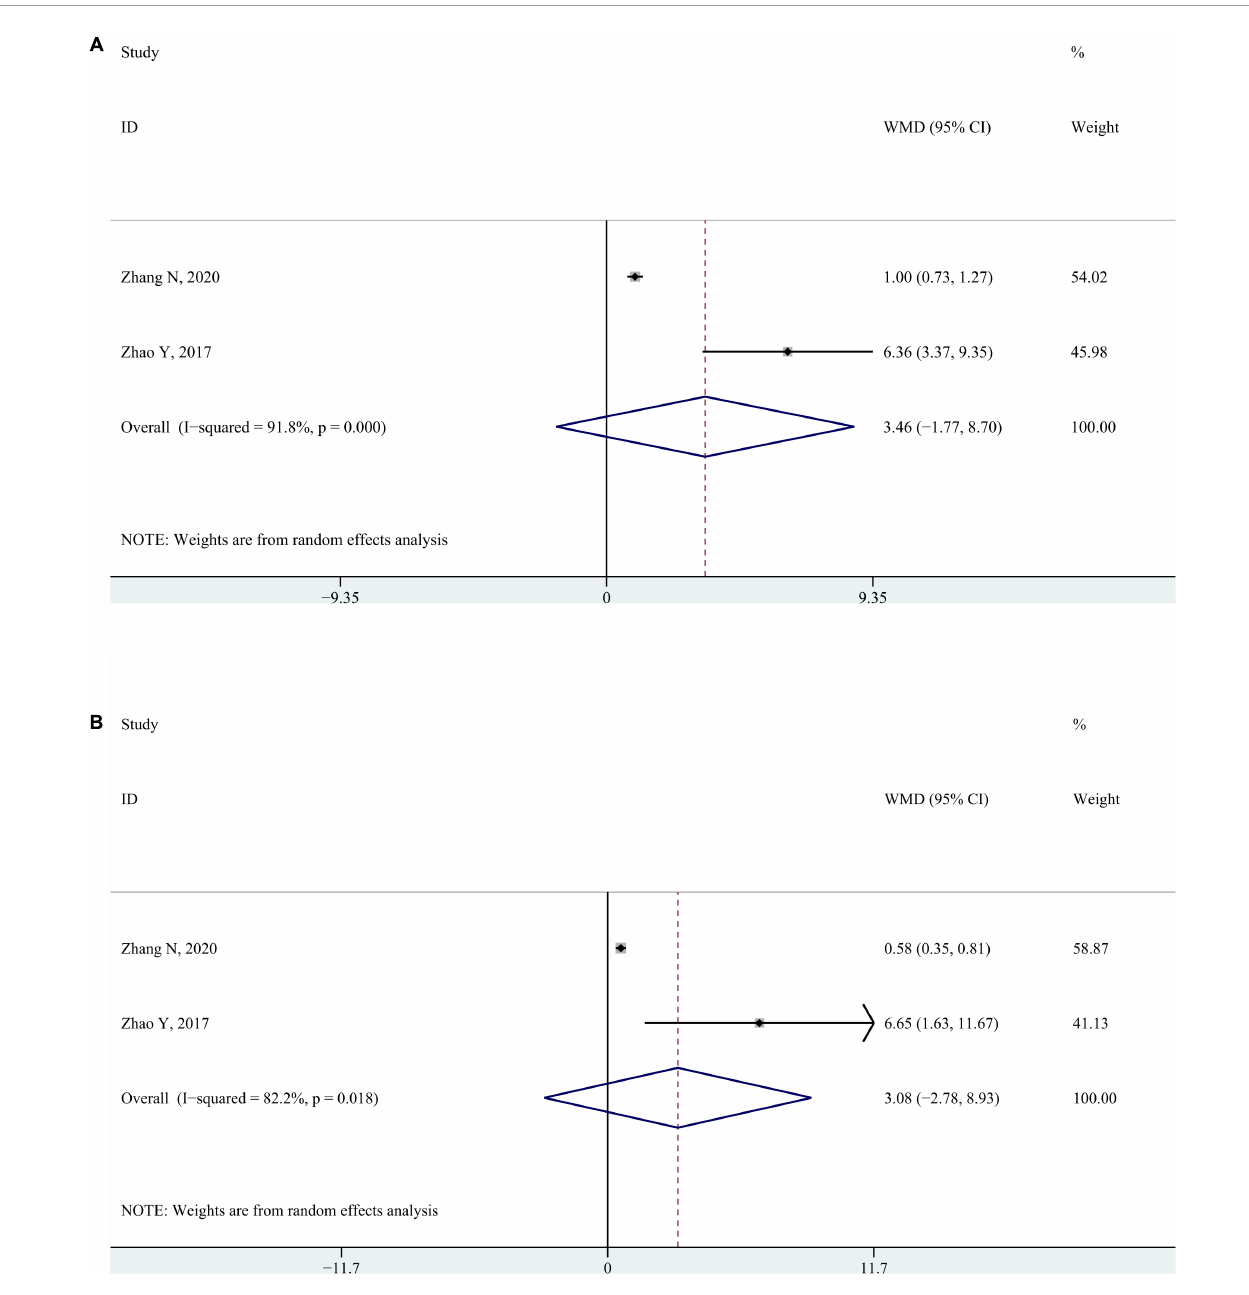
FIGURE3 Forest plot of pooled results for Peabody Development Motor Scales-II (A) Peabody Developmental Motor Scales–Grasping. (B) Peabody Developmental Motor Scales–Visual motor